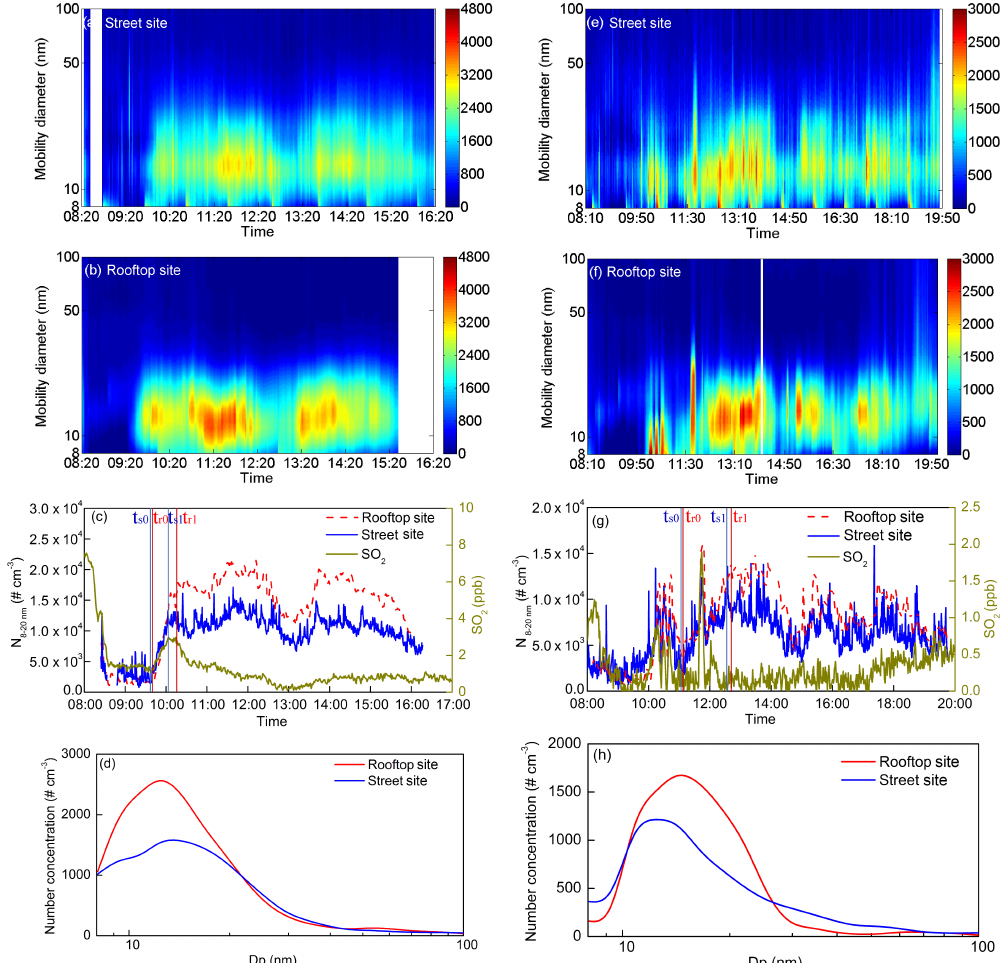
Figure 3. Contour plots, time series of number concentrations, and size distributions of atmospheric particles at two sampling sites on 27 April 2012 (left column) and 25 April 2012 (right column) ( a , b , e , f contour plots of particle number concentration (#cm − 3 ) ; c , g time series of nucleation mode PNC ( N 8–20nm ) and SO 2 mixing ratios at two sampling sites; d , h size distributions of N (ts 1 ) – N (ts 0 ) at the street site and N (tr 1 ) – N (tr 0 ) on the rooftop; N (ts 1 ) – N (ts 0 ) and N (tr 1 ) – N (tr 0 ) represent the number concentration at each size bin at t 1 minus that at t 0 at the street site and at the rooftop site,